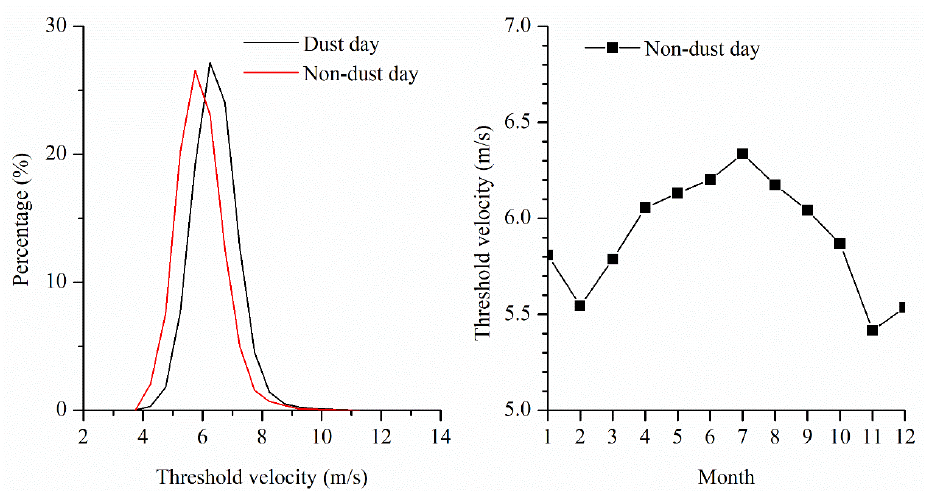
Figure 5. Frequency distributions of the threshold velocity on both dust and non-dust days ( left ) and monthly variations in the threshold velocity on non-dust days ( right ).